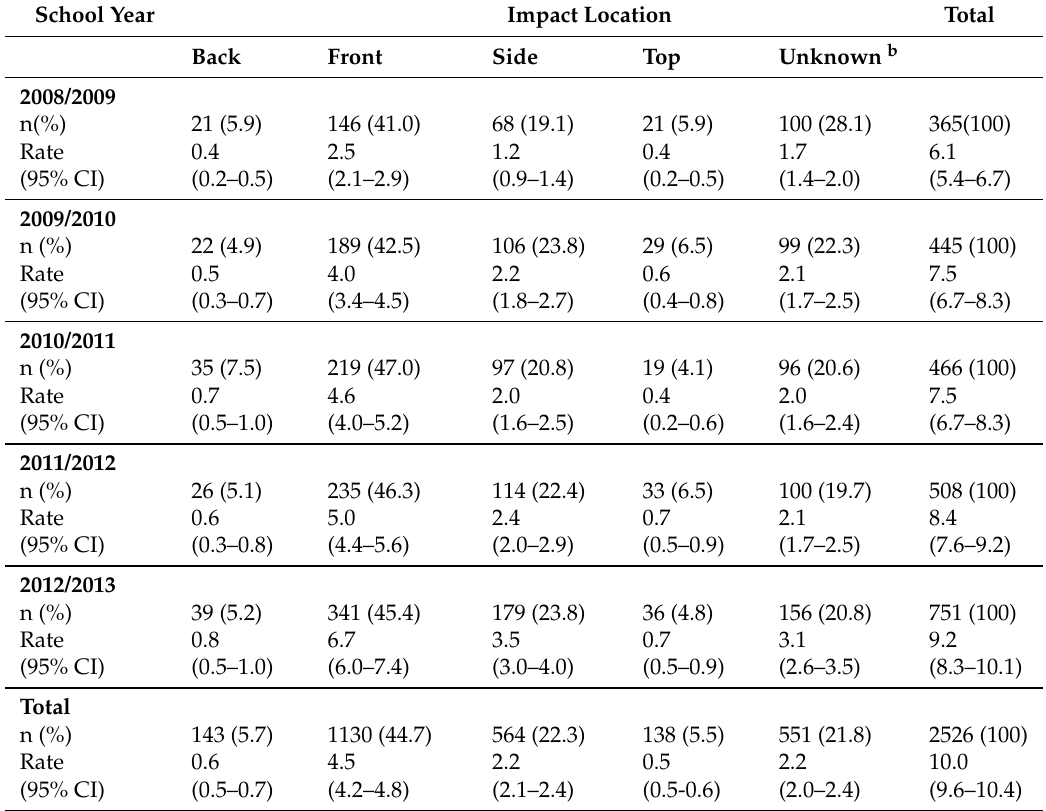
Table 3. Annual concussion data a (and 95% CIs), for American football players, regarding different school years and impact location